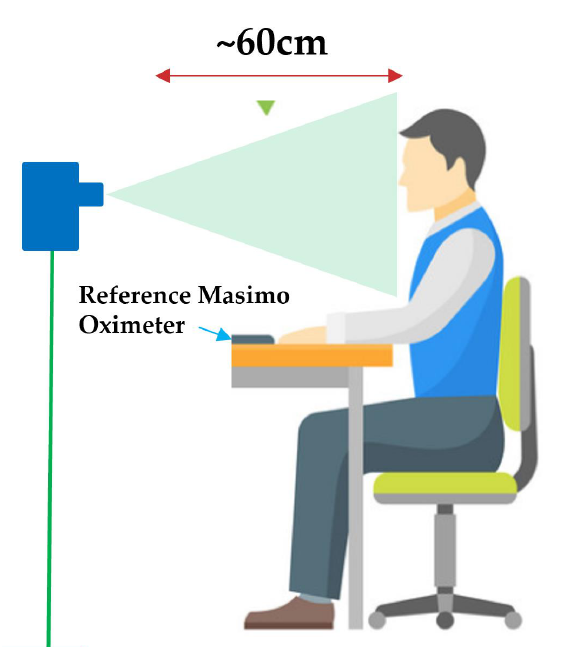
Figure 1. Experimental configuration for proof-of-concept HR, RR measurements using the Pico Flex indirect ToF